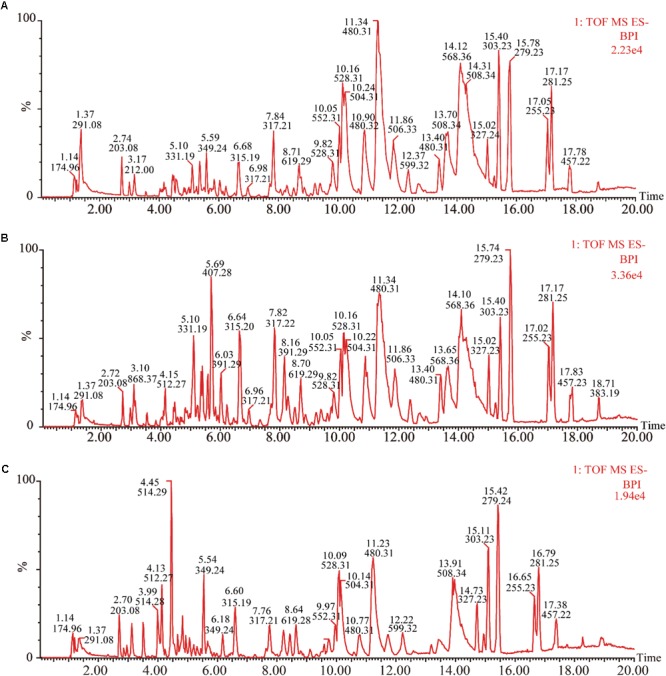
Representative base peak intensity chromatograms of plasma samples of different groups derived from UHPLC-QTOF/MS. (A) Control group, (B) model group, and (C) XSHG group.